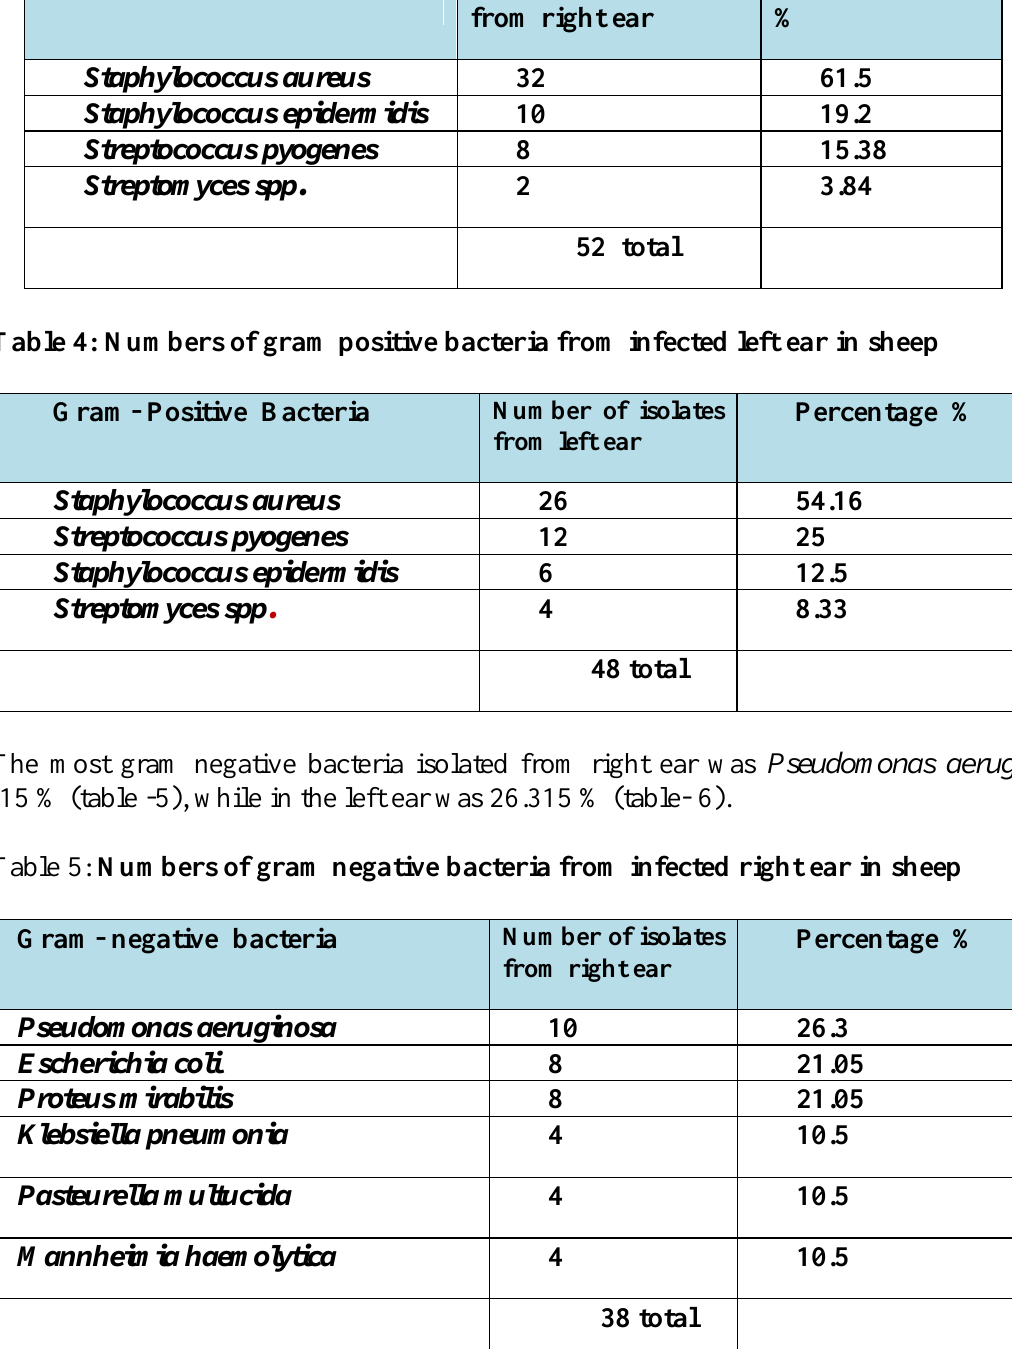
Table 3: Numbers of gram positive bacteria from infected right ear in sheep Percentage Gram- Positive Bacteria Number of isolates from right ear